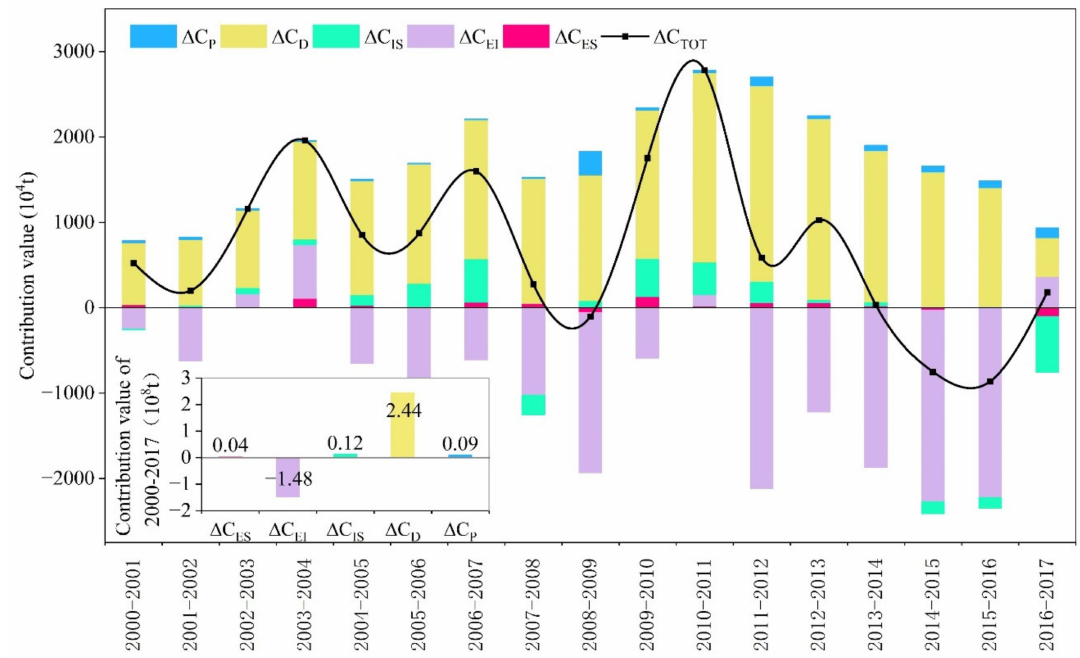
Figure 4. Additive decomposition results of Gansu’s CO 2 emissions changes from 2000 to 2017 and the entire period. Here, ∆ C TOT means the total CO 2 emissions changes over time; changes caused by population, economic output, industrial structure, energy intensity, and energy structure,